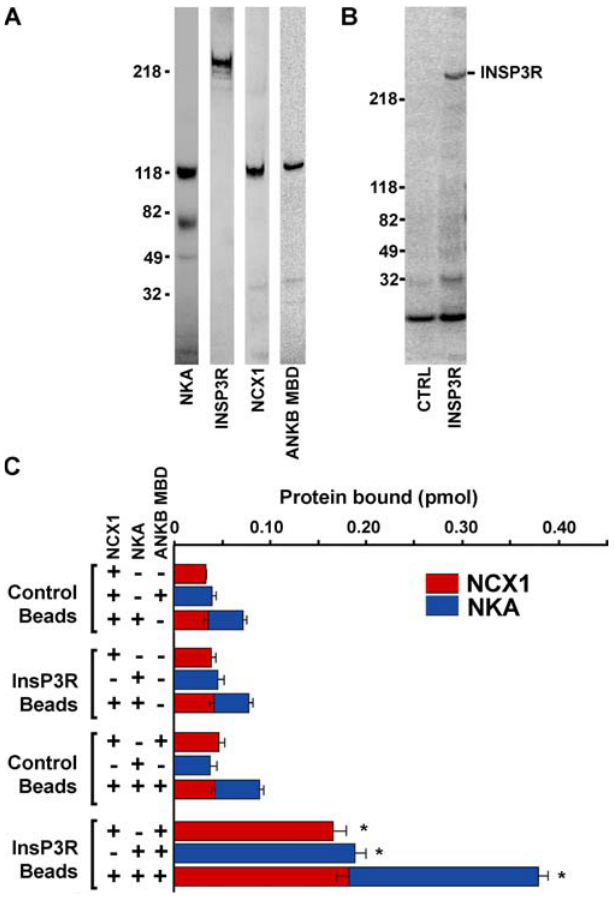
Figure 6. Reconstitution of the NCX1, NKA, and InsP 3 R Complex Requires Ankyrin-B (A) Purified NKA ( a / b subunits), InsP 3 R, NCX1, and ankyrin-B membrane- binding domain (ANKB MBD) were examined by SDS-PAGE and Coomassie blue. (B) Stained gel of control beads and beads plus purified InsP 3 R. (C) NKA and NCX1 were 125 I-labeled and incubated with control Dynabeads or Dynabeads coated with InsP 3 R with or without ankyrin-B membrane-binding domain. Bound protein was analyzed by a gamma- counter (C) and by SDS-PAGE and phosphorimaging (not shown; see Materials and Methods for protein measurement, n ¼ 3, p , 0.05). DOI: 10.1371/journal.pbio.0030423.g006